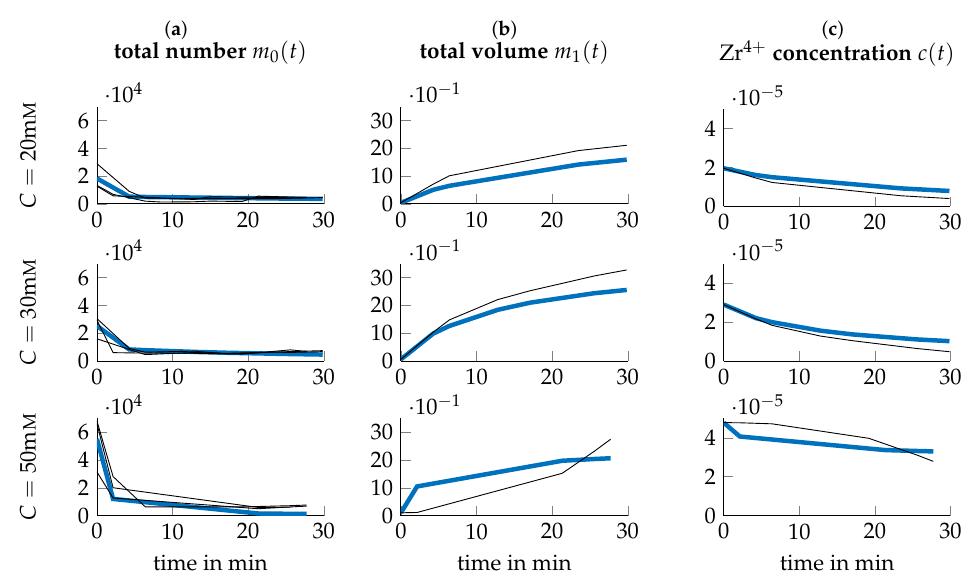
Figure 2. Data (black thin lines) and simulation (blue thick lines) for T = 40 ◦ C and different precursor concentrations C . Data obtained like in Figure 1.